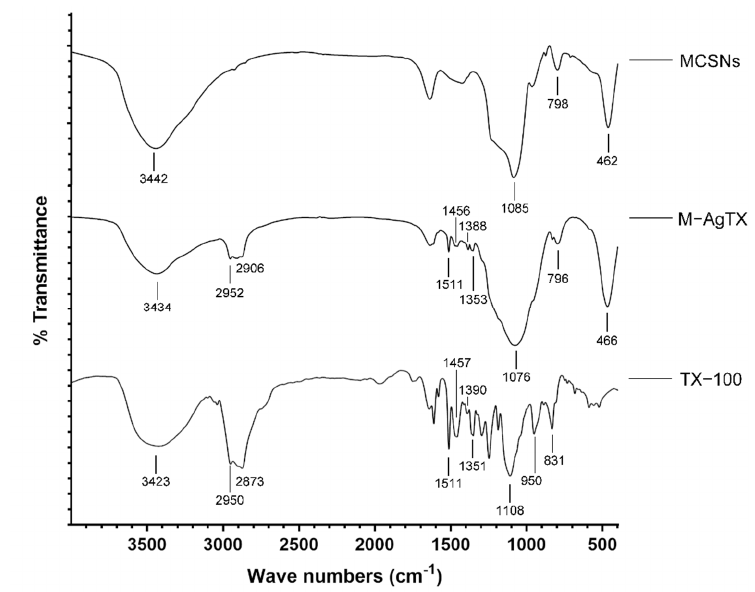
Figure 3. FTIR spectrum of MCSNs, M-AgTX and TX-100.